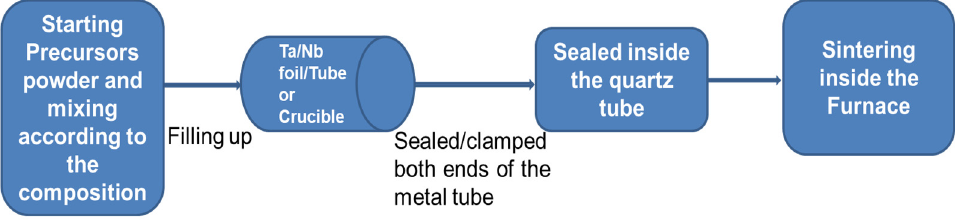
Figure 2. A general block diagram of the Solid-State Reaction (SSR) method for FBS.